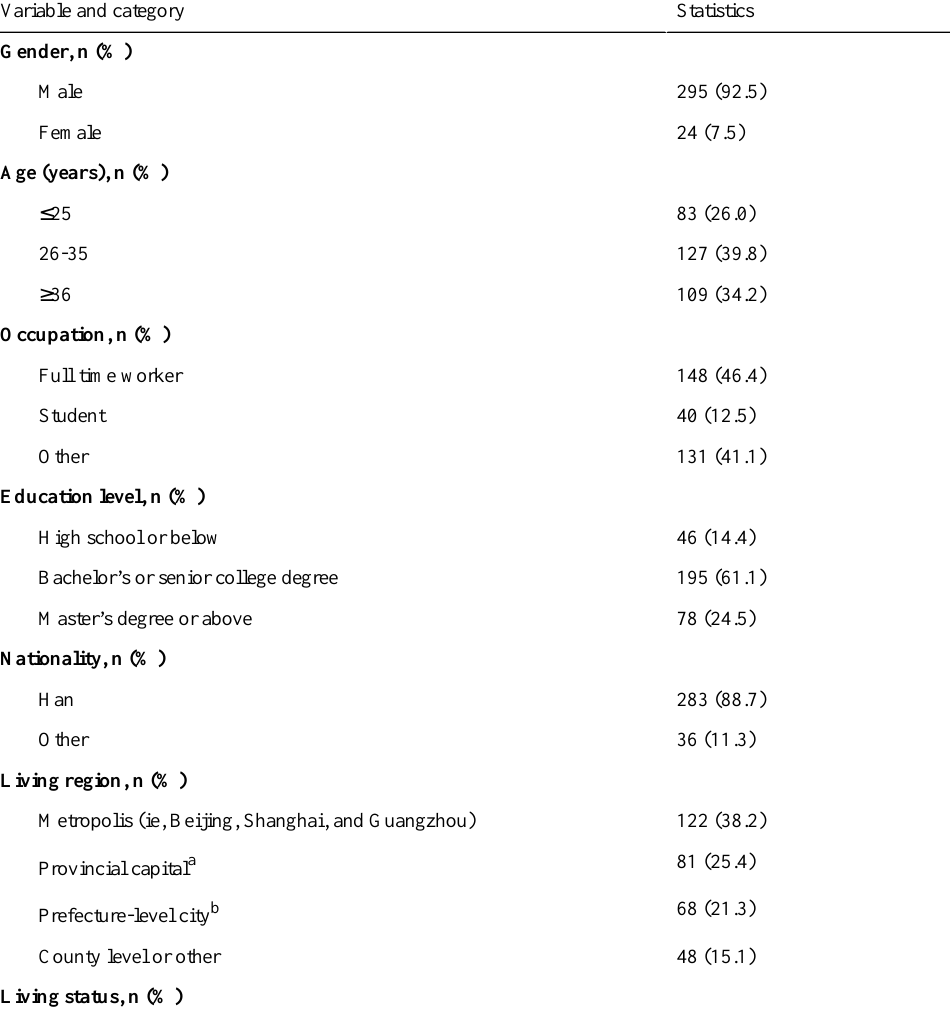
Table 1. Demographic characteristics of smokers